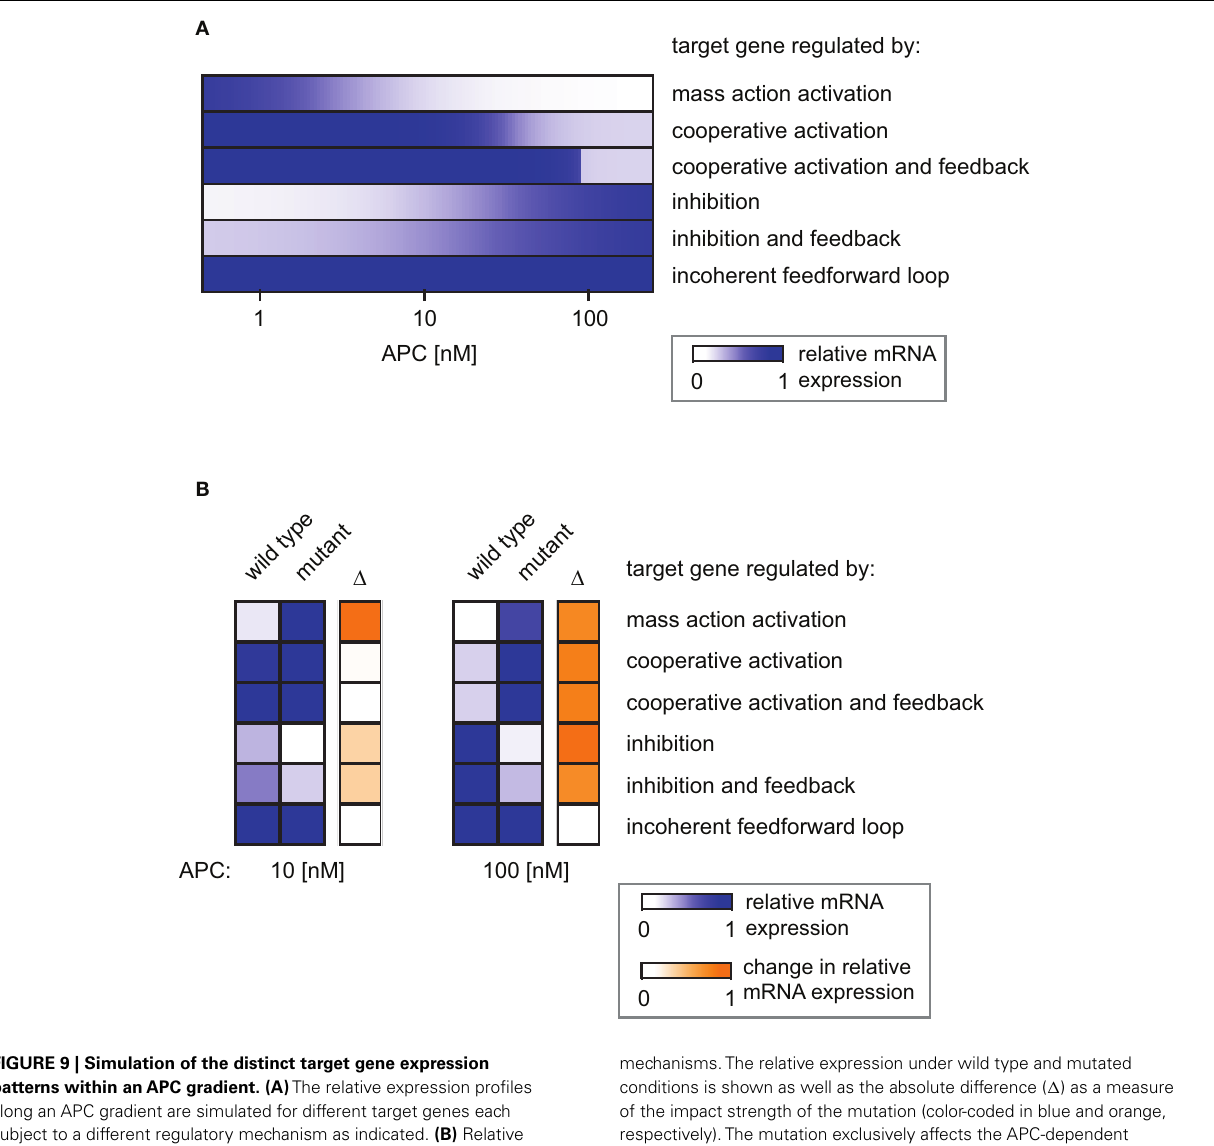
mechanisms.The relative expression under wild type and mutated conditions is shown as well as the absolute difference ( ∆ ) as a measure of the impact strength of the mutation (color-coded in blue and orange, respectively).The mutation exclusively affects the APC-dependent β -catenin degradation (reaction 3); the parameter k 3 in Eq. A10 is set to 1% of its original value in the mutant